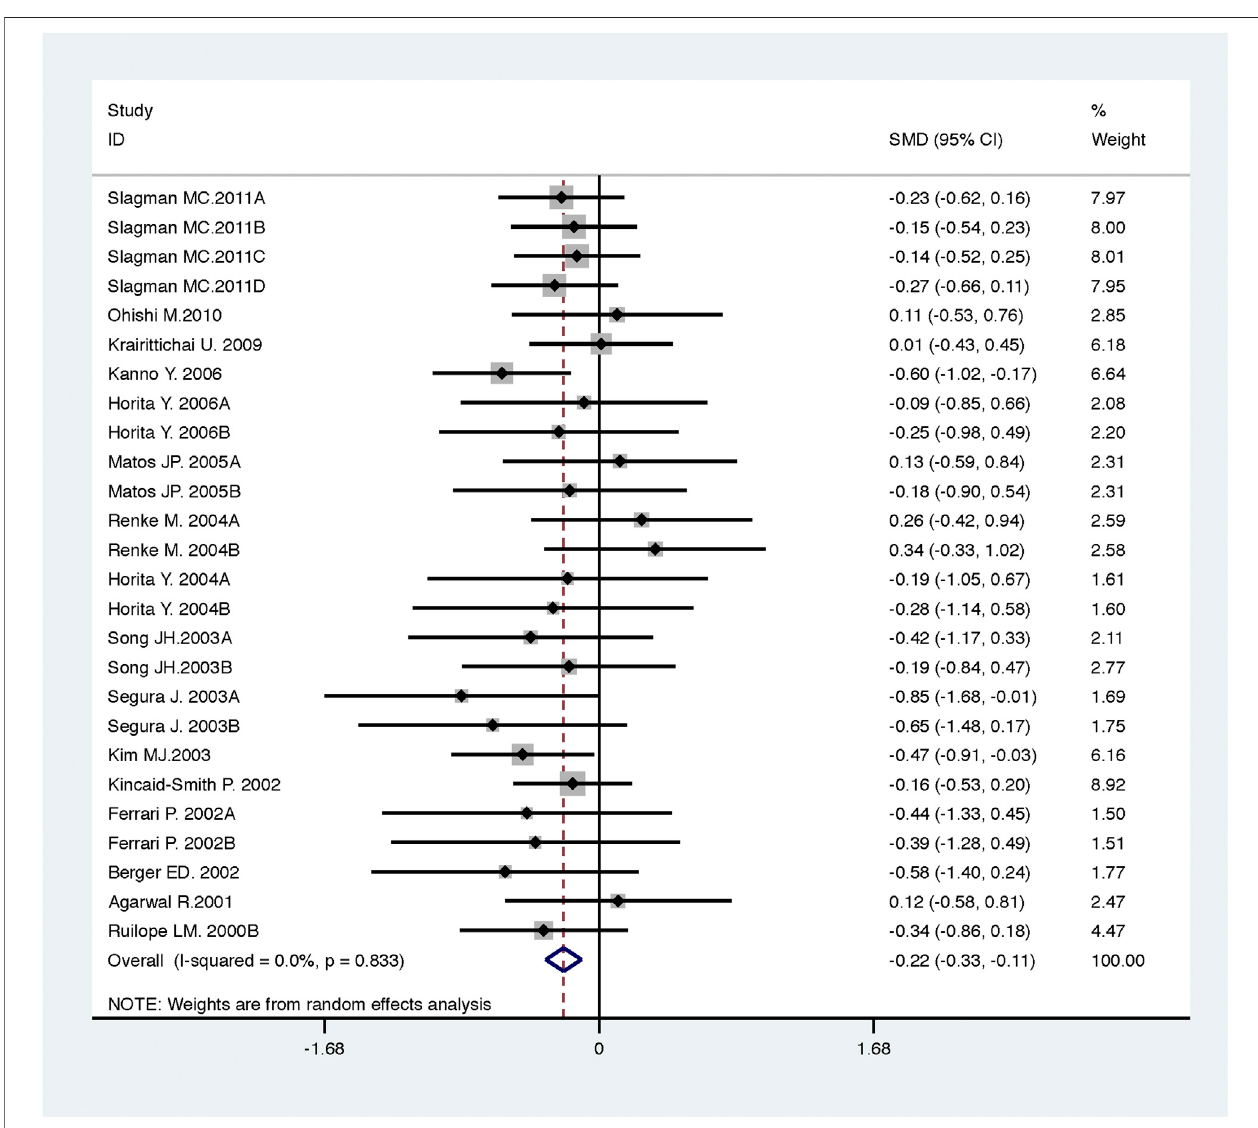
FIGURE 3 | Comparison of ACEI in combination with ARB vs. low-dose ACEI or ARB for urine protein excretion (g/g of creatinine or g/24 h).